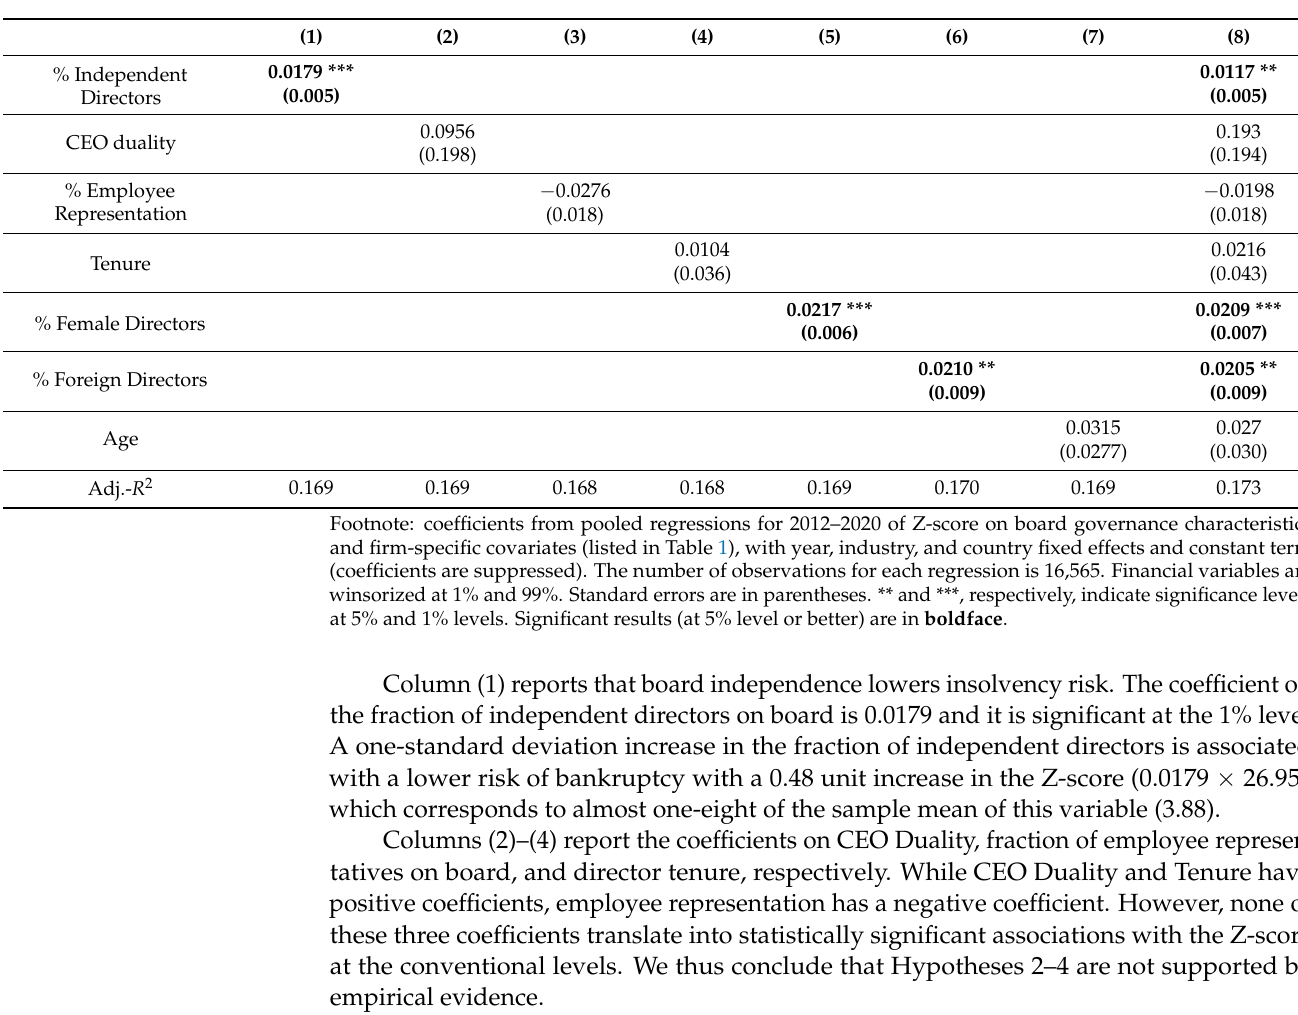
Table 3. Board Governance and Risk of